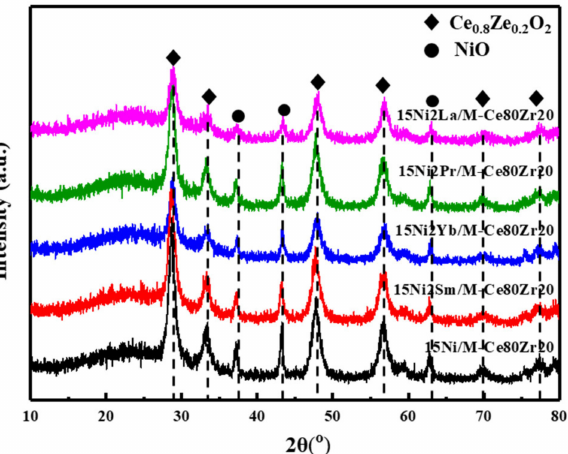
Figure 1. X-ray diffraction (XRD) patterns of the 15Ni2R/M-Ce80Zr20 (R = La, Sm, Pr, Yb)